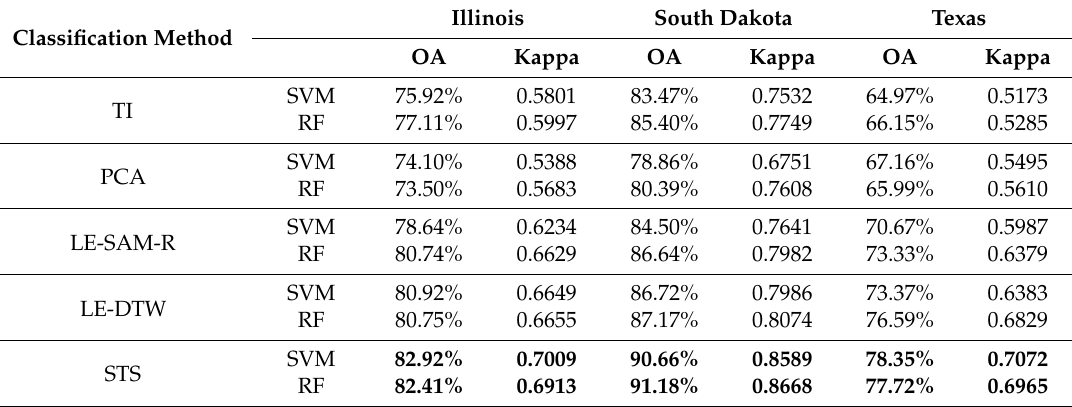
Table 2. The overall accuracies and kappa index of five classification